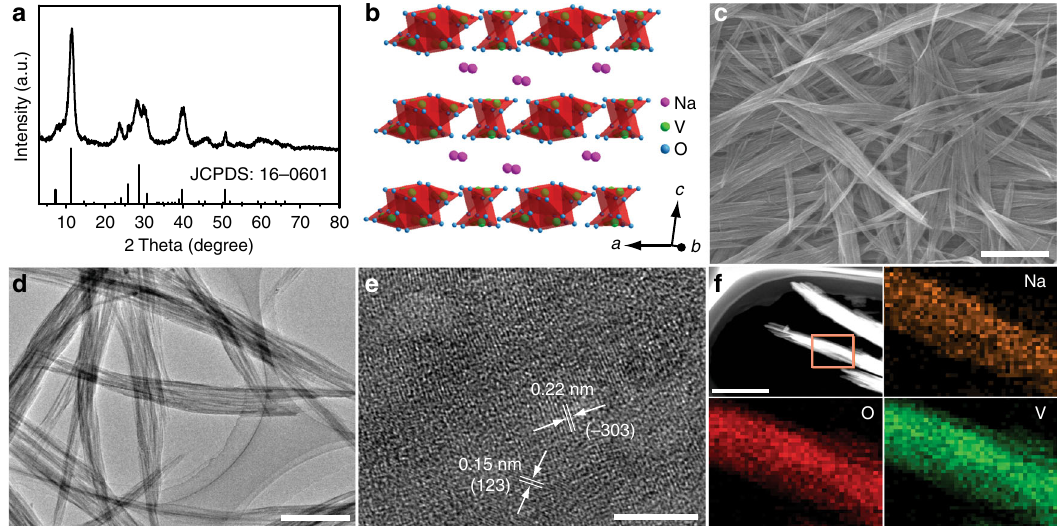
Fig. 1 Crystal structure and morphology of NVO. a XRD pattern of NVO nanobelts. b Crystal structure of NVO nanobelts, Na + exists in the form of hydrated ion. c SEM, d TEM, e high-resolution TEM, and f TEM elemental mapping images of NVO nanobelts. Scale bars of 1 μ m, 200, 5 and 400 nm,